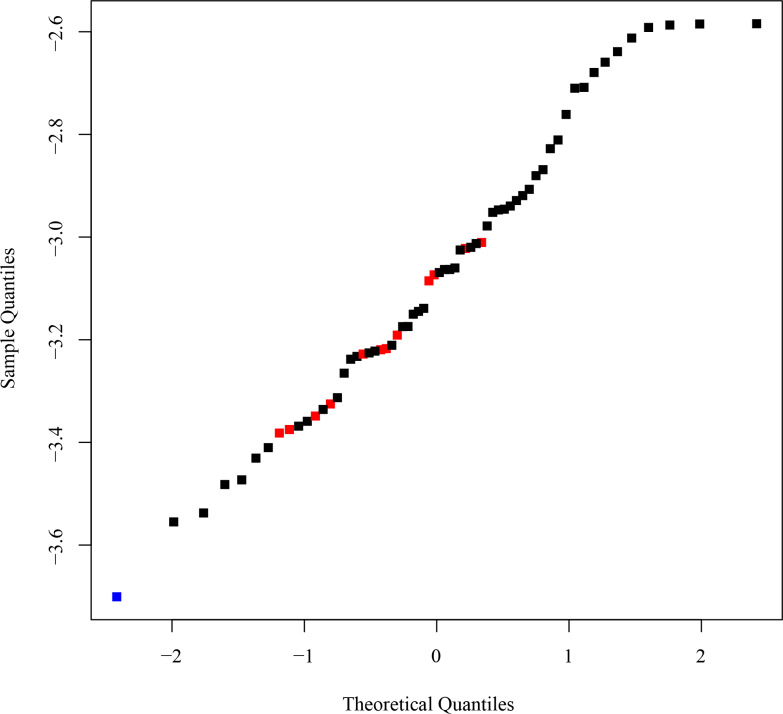
Quantile-quantile plot of BEAST rates for concatenated chloroplast markers.The quantile-quantile plot of log10 transformed branch rates is shown for the concatenated chloroplast dataset in BEAST. The values for the Isoetes stem branch (blue) and crown branches (red) are highlighted.